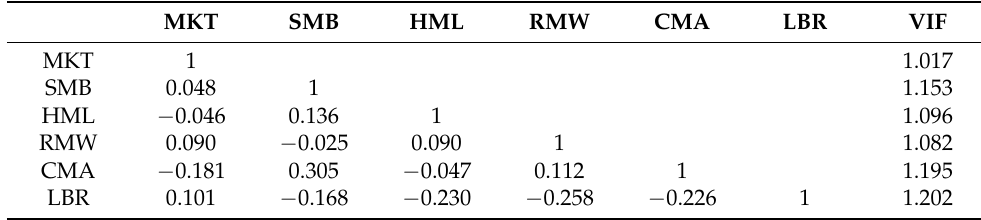
Table 3. Correlation matrix of the six